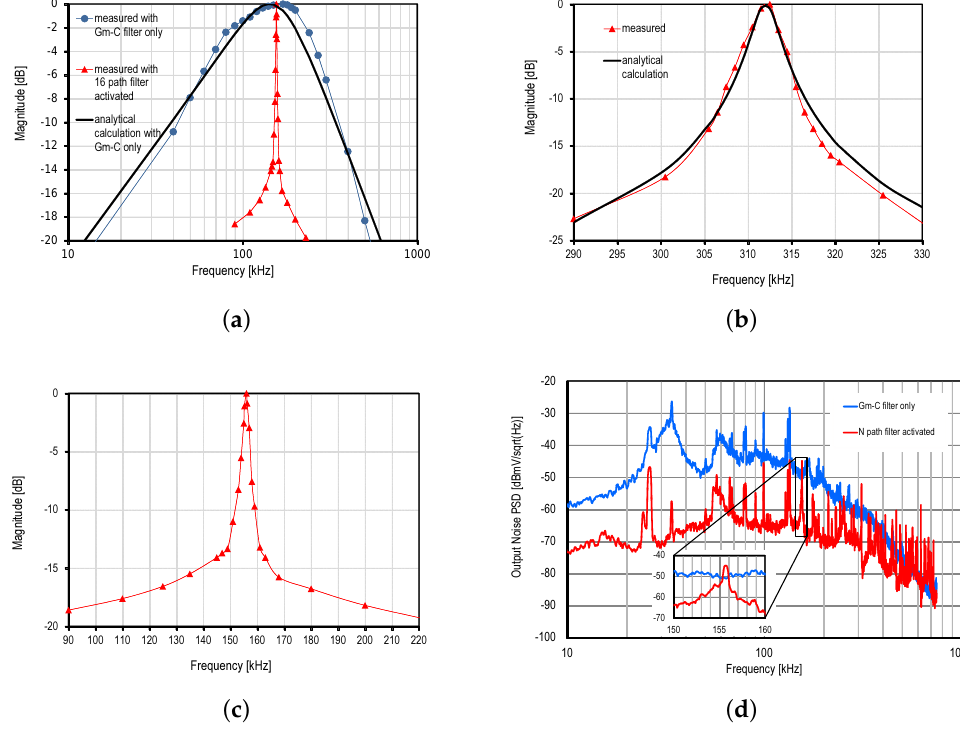
Figure 11. Characterization of the in-pixel baseband circuit with a measured readout chain gain of 58 dB. ( a ) The transfer function (log frequency scale) when the N-path filter is bypassed, compared to the analytical calculation and with the N-path filter activated; ( b ) the measured transfer function (linear frequency scale) when both filters are activated and centered at 312 kHz compared to the analytical calculation; ( c ) measured transfer function (linear frequency scale) when both filters are activated and centered at 156 kHz; ( d ) the output noise PSD obtained when both filters are activated and when the N-path filter is bypassed with a zoom onto the center frequency of the N-path